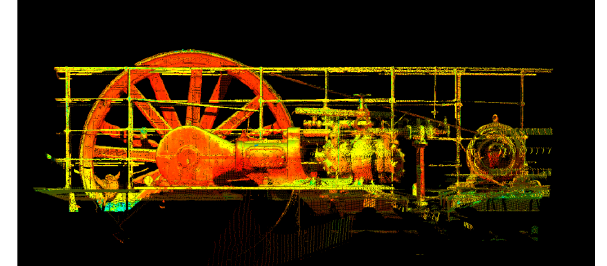
Figure 12. Lateral view (in reflectance colors) of a machinery of the refrigeration system.